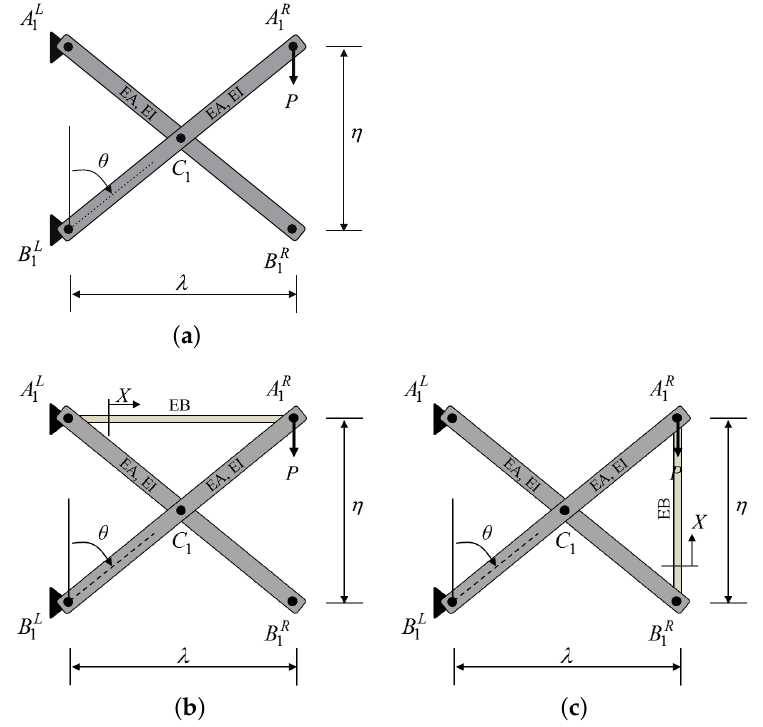
Figure 3. Calculation examples in cantilever model: ( a ) model without strut member; ( b ) model with upper horizontal strut member; ( c ) model with right vertical strut